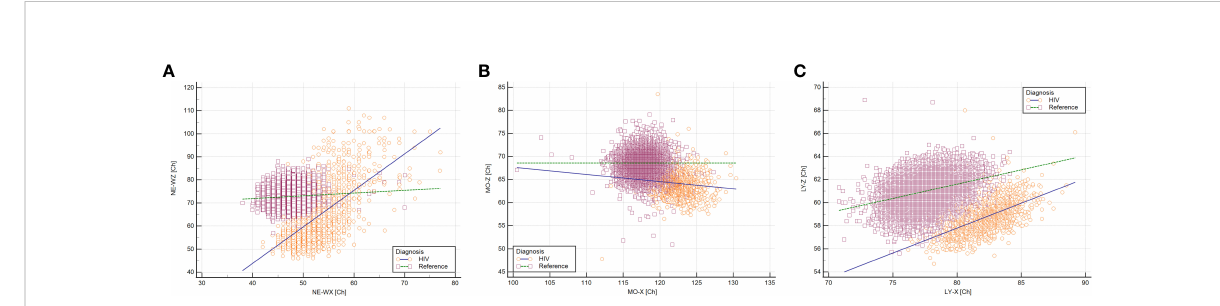
FIGURE 3 Neutrophils, monocytes and lymphocytes of PLHIV are distinct from people without HIV in Sysmex hemocytometry. Based on selected white blood cell characteristics, N = 1895 PLHIV (orange circles) with suppressed viral loads could easily be distinguished from N = 15,803 people without HIV (purple squares). (A) Neutrophils of PLHIV were unique in terms of intra-individual variability in both size and complexity. (B) Monocytes of PLHIV were distinct in size and complexity. (C) Lymphocytes of PLHIV were different in size and